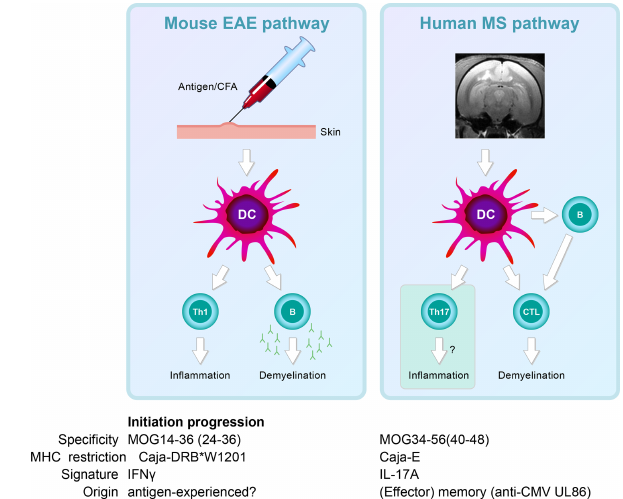
Figure 8. Two autoimmune pathways. EAE development in the rhMOG/CFA model involves two distinct pathogenic mechanisms. The 100% EAE incidence (see Fig. 7a) maps to the MHC class II/Caja-DRB*W1201-restricted activation of Th1 cells specific for MOG epitope 24–36. The signature cytokine of this pathway, which essentially replicates mouse EAE models, is IFN γ . Early blockade of IL-12/IL-23 with a mAb against IL-12p40 abrogates the activa- tion of this pathway. The observation that the EAE initiation path- way is activated in rhMOG/IFA model indicates that the responsive Th1 cells may be antigen-experienced cells. The variable EAE on- set maps to another pathogenic mechanism, namely the MHC class I/Caja-E-restricted activation of CTL specific for MOG epitope 40– 48, which shares almost complete sequence similarity with an epi- tope from the major capsid protein of CMV. The signature cytokine of this pathway is IL-17A. The characteristics and specificity of the CTLs suggest that they originate from the effector memory T cells that keep CMV under control. We hypothesize that the variable ac- tivation of the latter pathway is induced by antigens released from white matter lesions induced by the former